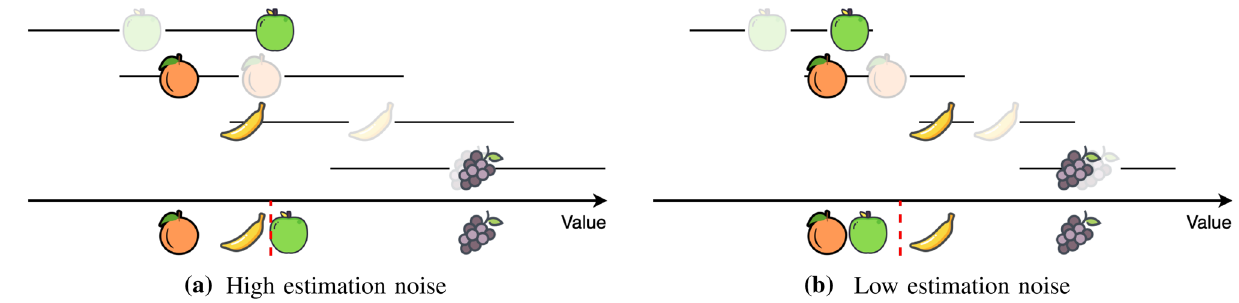
Fig. 1 Prioritizing four projects (the fruits) according to their value ( x -axes). The semi-opaque icons represent the projects’ true value, and the solid icons represent possible project value estimates under some level of uncertainty (horizontal lines) in the estimation pro- cess. (Top) Under a noisy estimation process, projects with a low